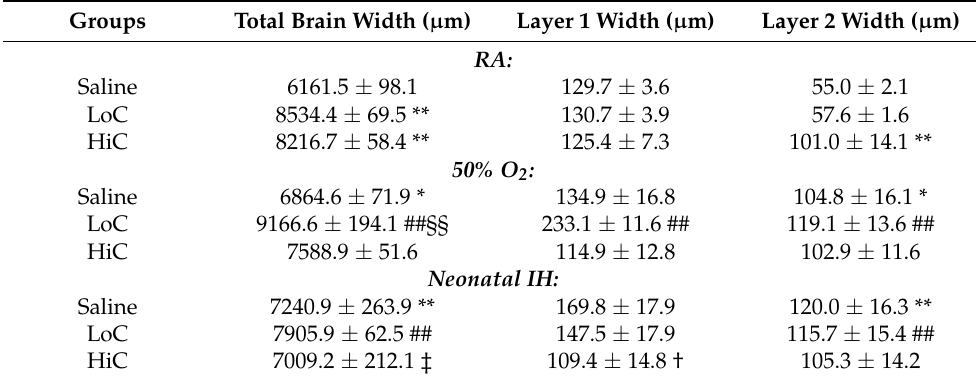
Figure 2. Representative H & E stains of cerebral cortex at P14. Groups are as described in Figure 2. Images are 20 × magnification. Scale bar is 50 µ M. Groups exposed to placebo saline in RA showed no abnormalities and layers were clearly defined. Hx resulted in loss of cells in the external granular layer (layer II) with reduced distinction of the layers (arrow). Neonatal IH resulted in severe hemorrhage (arrow), but with less reduction in layer II stellate cells. HiC in RA and Hx showed elongated irregular nuclei (arrows). HiC in neonatal IH also showed reduced layering and persistence of hemorrhage (arrow). Table 2. Brain Morphometric Analyses.